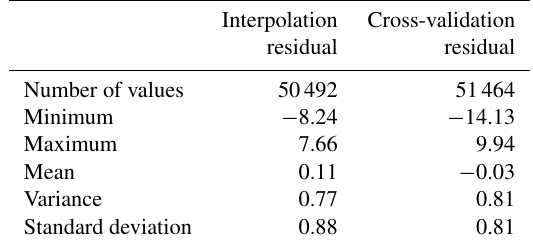
Table 2. Residual statistics for the Austrian data set. Units in milli- gals